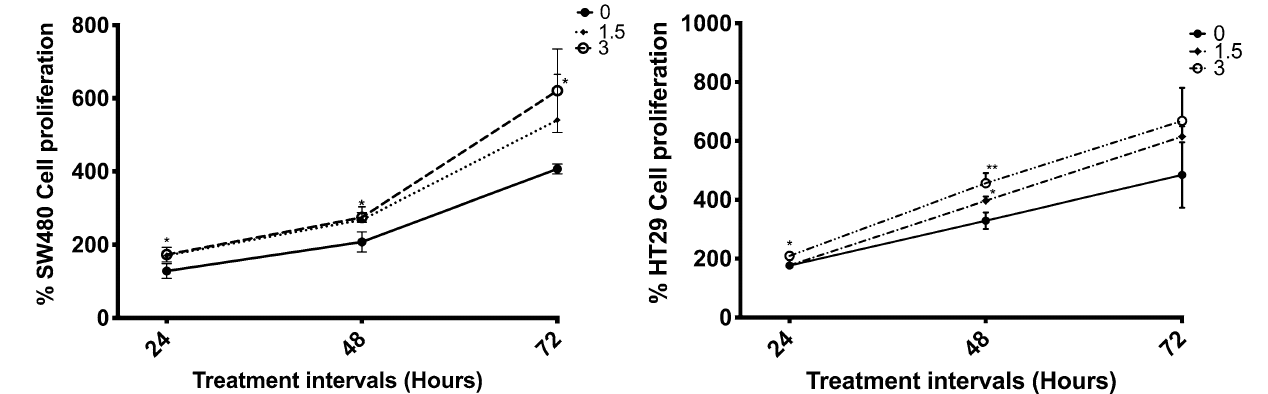
Figure 1. ZEA promotes the growth of human CRC cells. Cultured CRC cells (SW480, HT29) were treated with 0–3 μM ZEA for 24, 48 and 72 h. CRCs were then trypsinized and fixed with trypan blue solution. Cell counting was carried out using LUNA Automated Cell Counter. Results shown are mean ± SEM, n = 3. *p < 0.05 and **p < 0.01 compared to